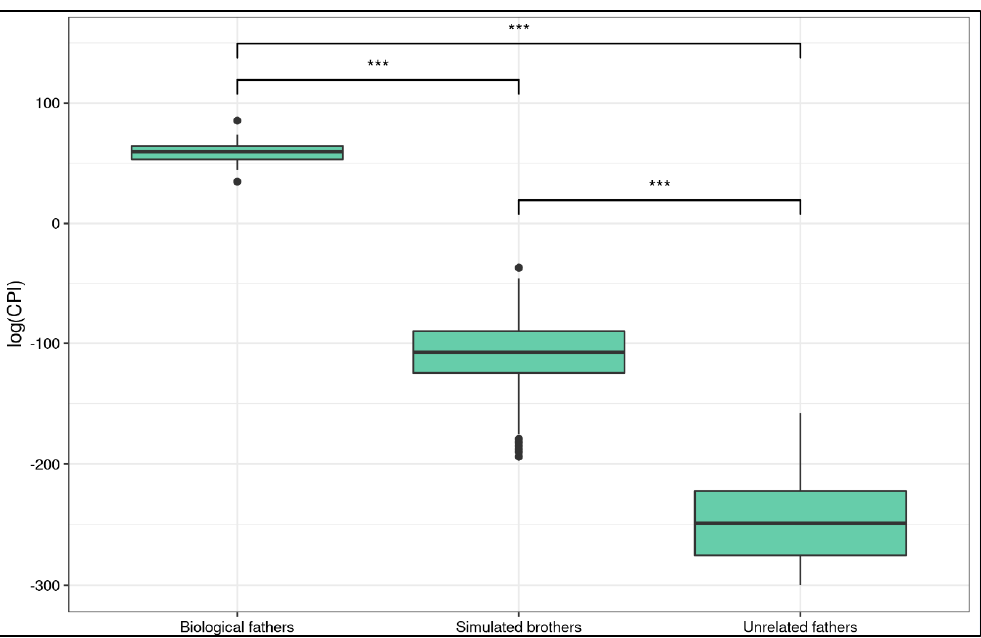
Figure 2. Log(CPI) distribution in different groups. The boxplot shows the comparison among biological fathers, simulated brothers and unrelated fathers. Stars report Wilcoxon test p ‐ value (*** is p ≤ 1.146 × 10 − 6 ).